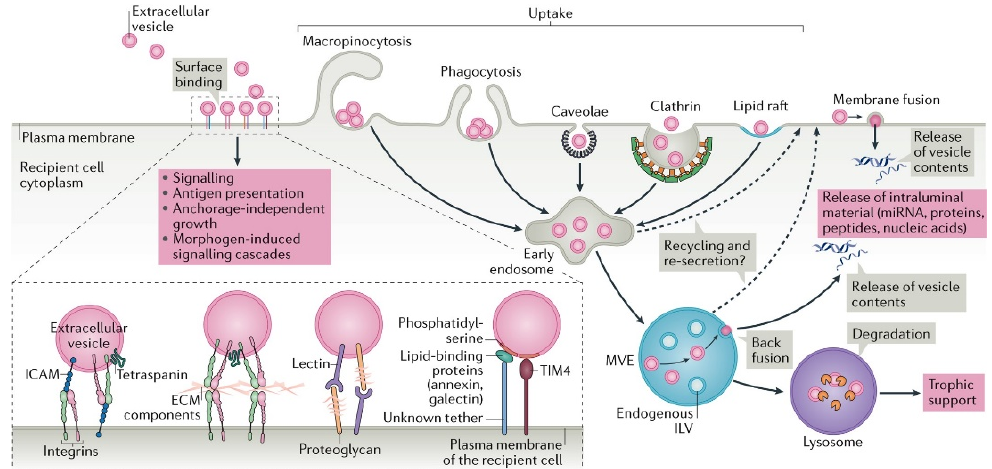
Figure 3. Visual representation of receptor-mediated endocytosis, macropinocytosis, phagocytosis, and membrane fusion of EVs into recipient cells as a means of intercellular communication. Reprinted by permission from Springer Nature Customer Service Centre GmbH: Springer Nature, Nature Reviews Molecular Cell Biology [46] .